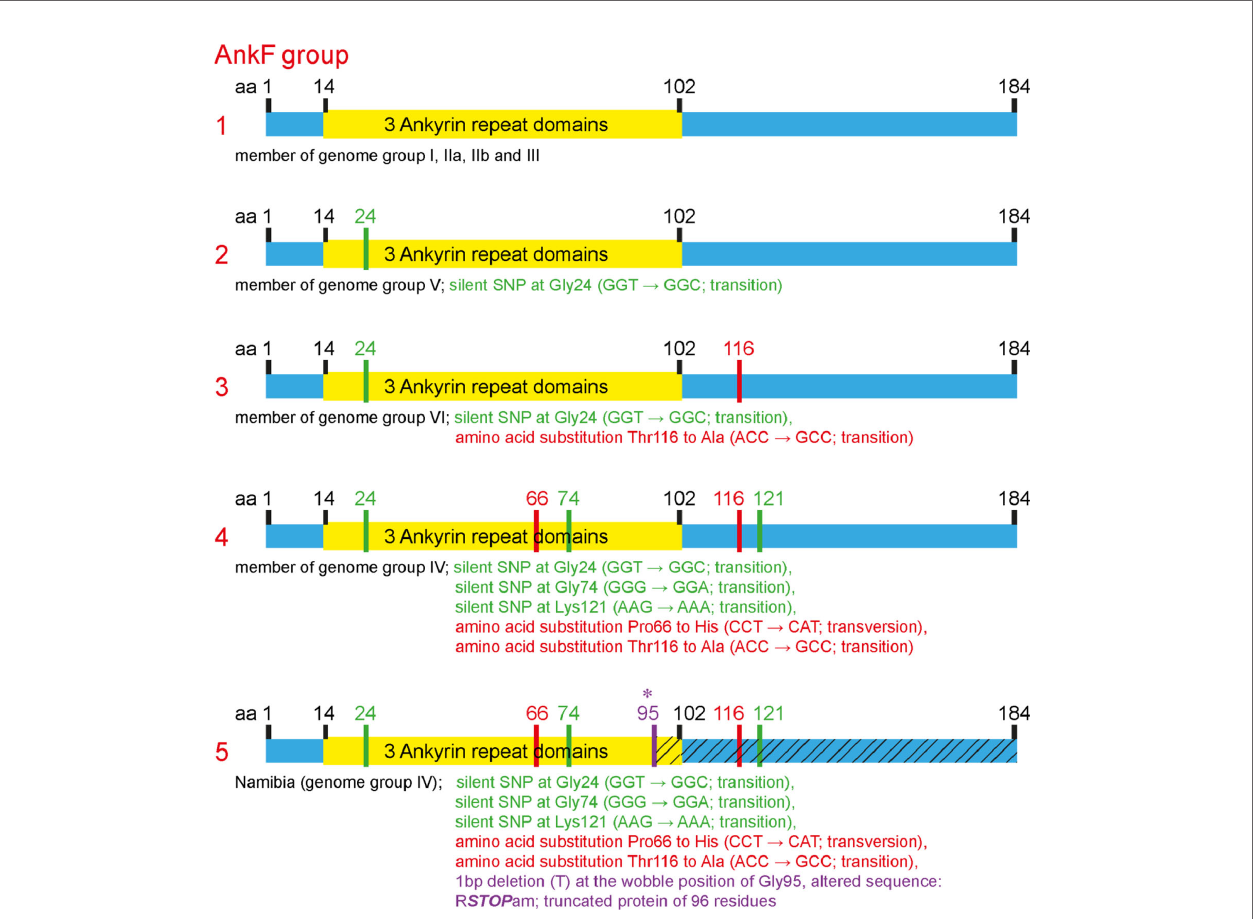
FIGURE 1 | Schematic diagram of fi ve alleles of the ankF gene. The sequences of the respective ankF gene from 52 C. burnetii strains ( Table 3 ) were analyzed. Depicted are the three ankyrin repeat domains (in yellow), silent nucleotide polymorphisms (in green), nucleotide exchanges (in red) and a frameshift mutation leading to a premature stop (in purple; marked with *). Beneath the diagram of the alleles, the corresponding C. burnetii genome group and the nucleotide substitutions are